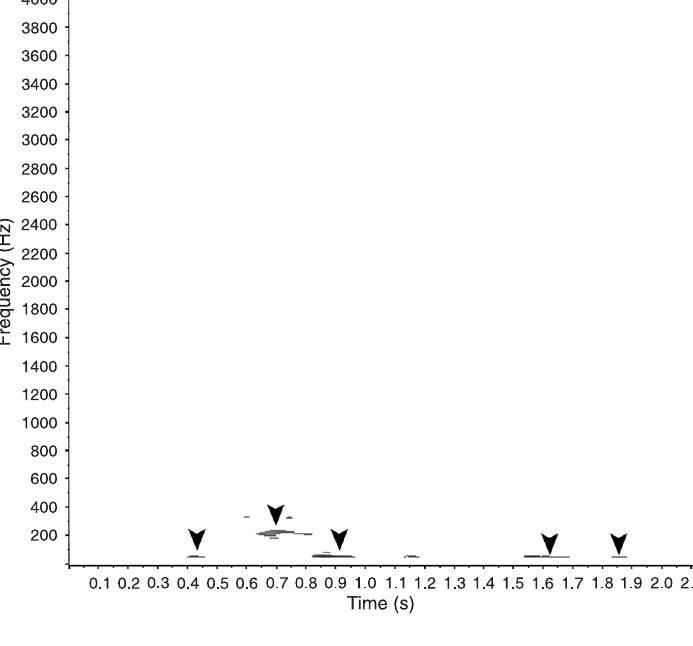
Figure 7. Spectrogram presented in Figure 3 af- ter applying the Laplacian 9 x 9 mask and thresh- old. The arrowhead points to the horizontal line, which represents the wheeze’s main frequency that was maintained intact after